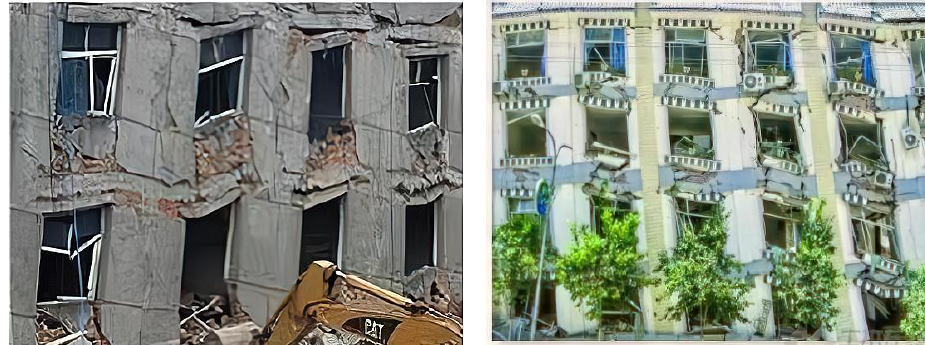
Figure 3. Damaged precast floor slab and spandrel in Ya’an, Sichuan, China.